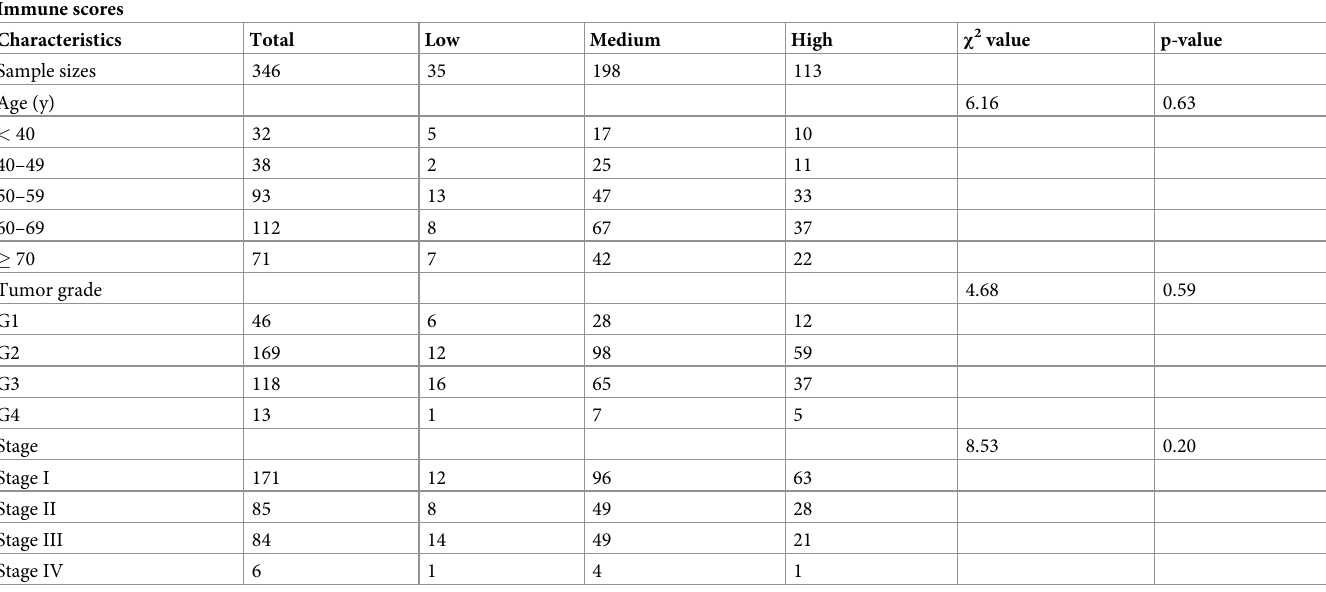
Table 1. Associations between clinicopathological features and immune scores in 346 liver cancer patients.